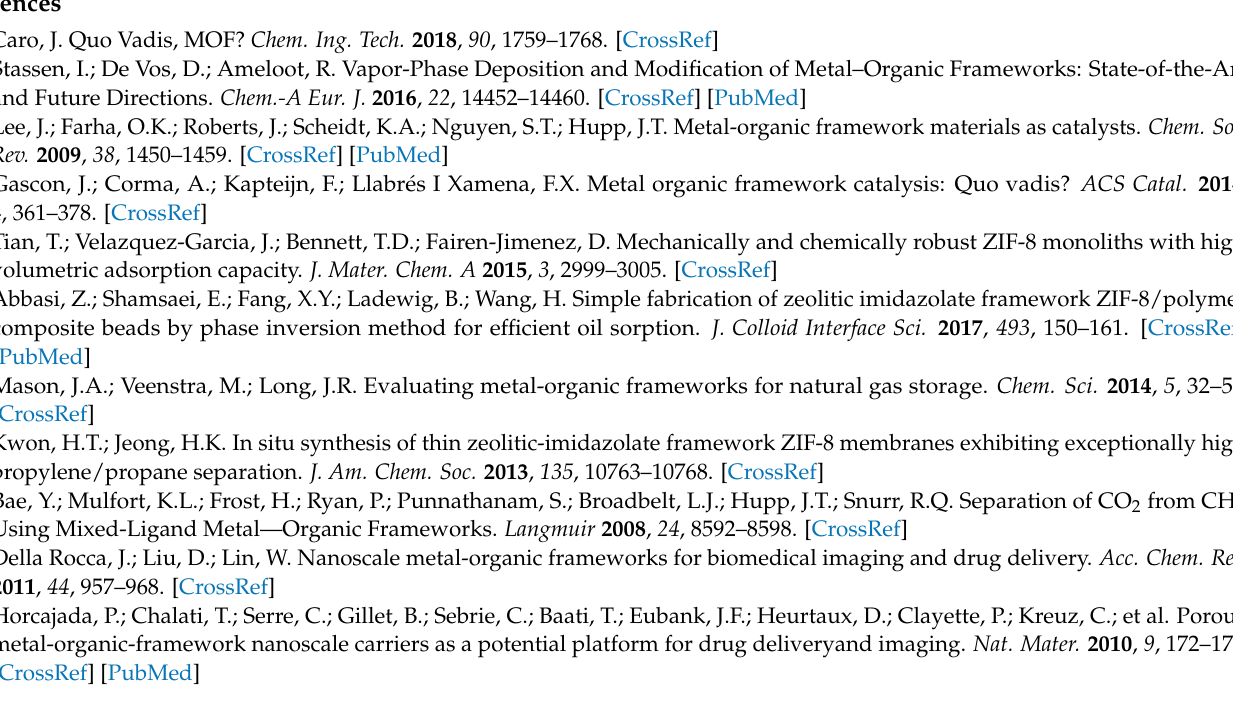
Figure S3: Additional GIXRD images, Figure S4: Schematics of different orientations of ZIF-8, plotted in Mercury [45], Figure S5: Additional SEM images, Figure S6: AFM topography images, Table S1. Overview of the varied deposition parameters and of the properties of the synthesized